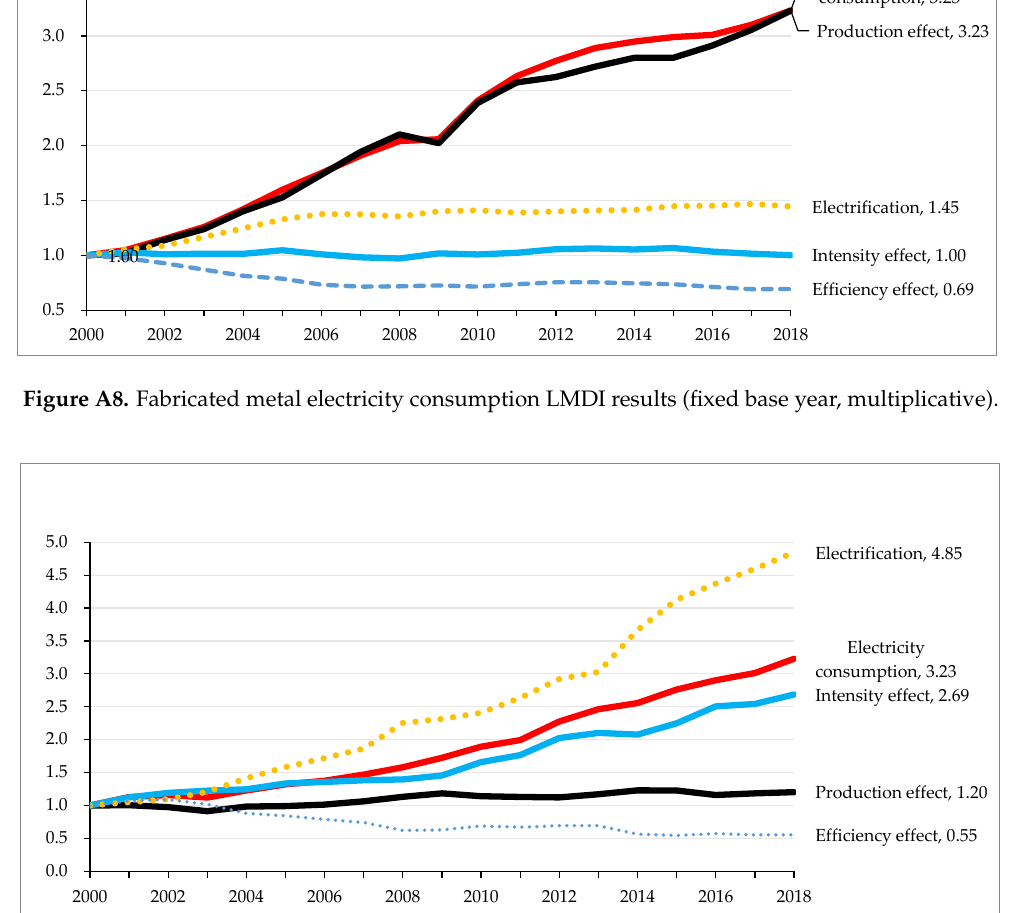
Figure A9. Agriculture/forestry/fishing electricity consumption LMDI results (fixed base year, multiplicative).